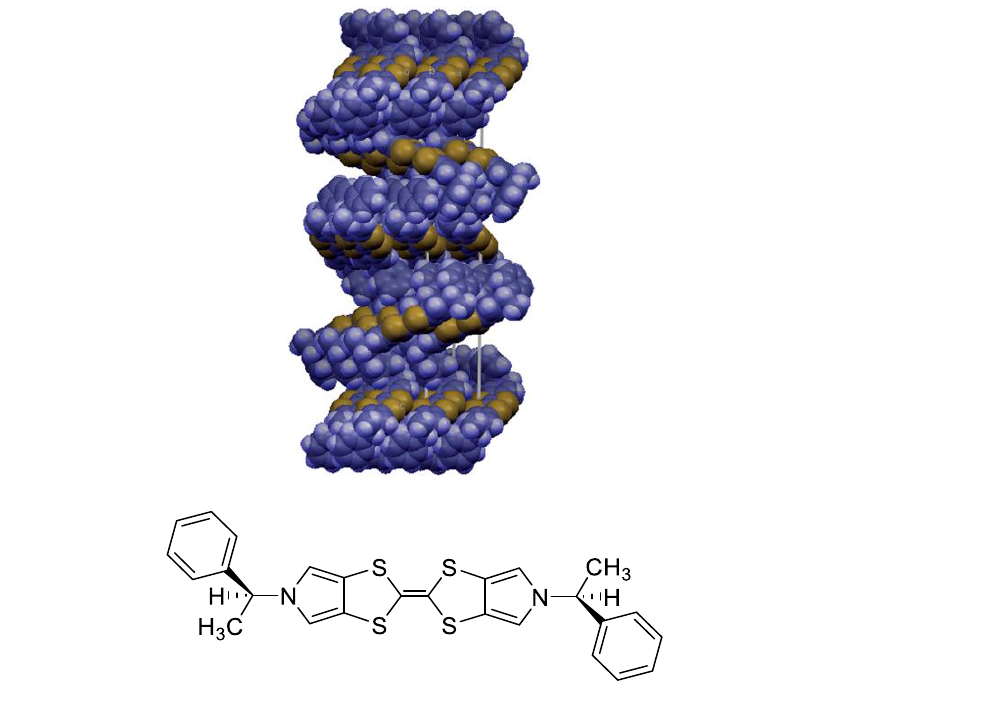
Figure 11. Organic crystal with a chiral molecular arrangement (upper; Space Group P 1) containing a bis(pyrrolo)tetrathiafulvalene derivative (lower). The donor packing motif represents a 4 3 axis along the c axis (vertical). Reproduced and modified from Ref. [934] with permission from The Royal Society of Chemistry.